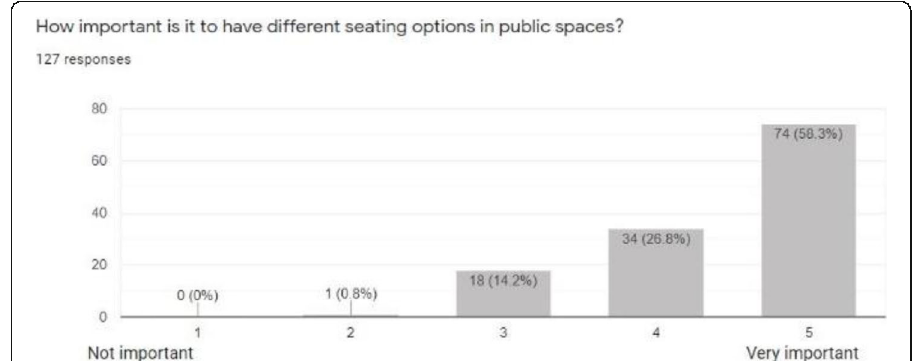
Fig. 21 Importance of seats with a variety of options (Author)